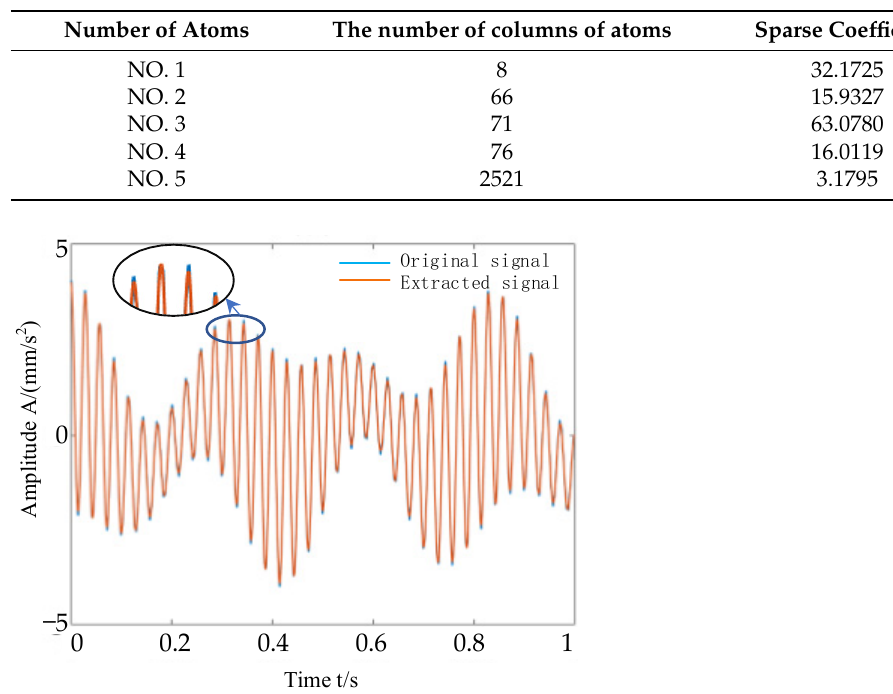
Table 3. Sparse representation coefficients of different atoms.